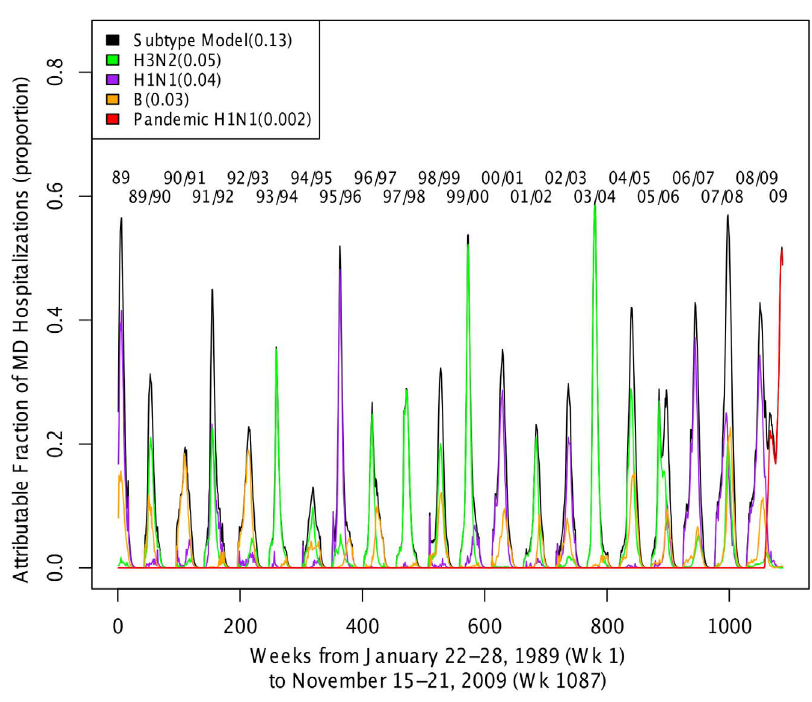
Figure 3. Weekly fraction of MD attributable to all subtypes together and individual influenza subtypes. Most seasons were dominated by either influenza A/H1N1 or A/H3N2, with little of the other subtype. Nearly all seasons also showed a smaller contribution from influenza B.